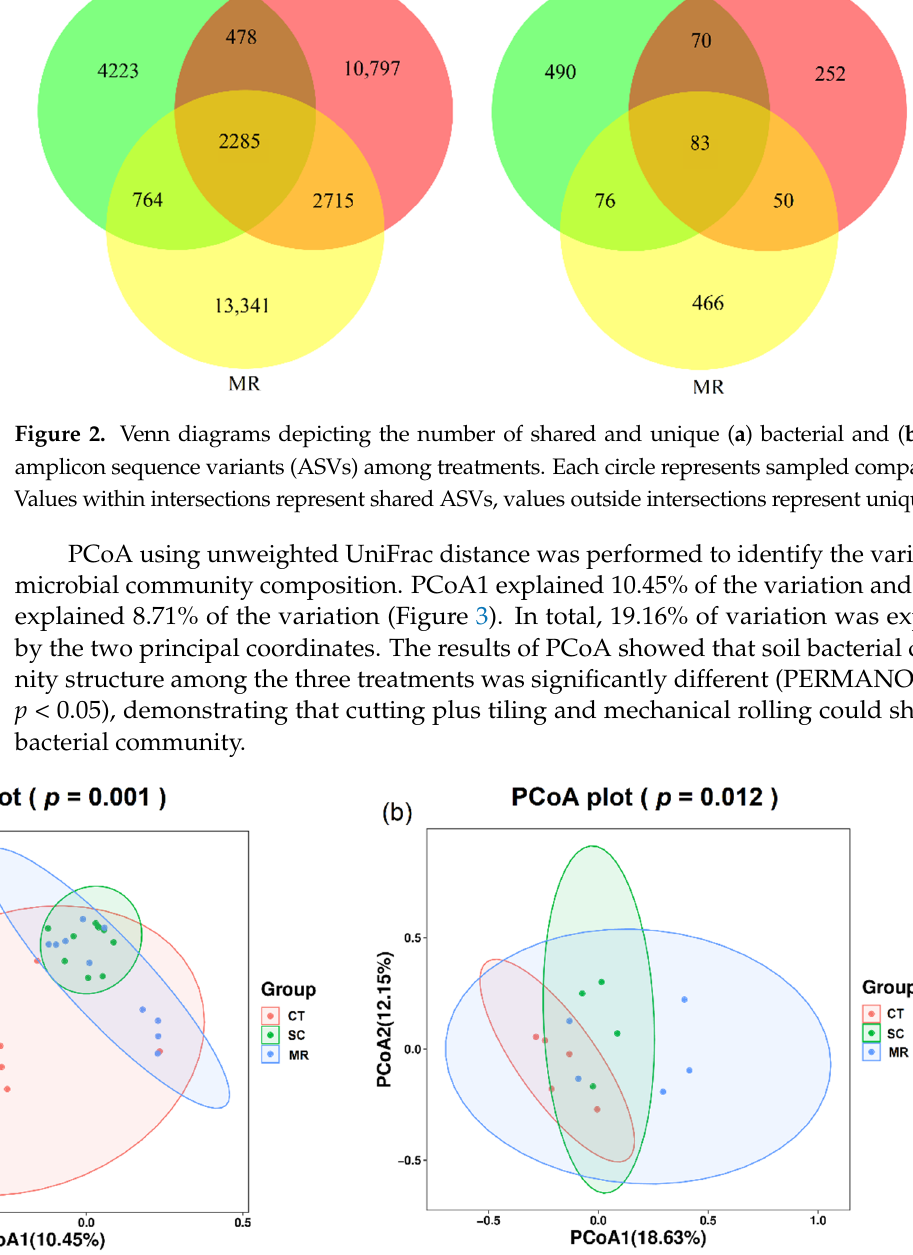
Figure 1. Differences in alpha diversity indices of bacteria (( a ). Chao1; ( c ). Shannon) and fungi (( b ). Chao1; ( d ). Shannon). One asterisk (*) represents significant difference ( p < 0.05) and two asterisks (**) represent highly significant difference ( p < 0.01) between treatments.